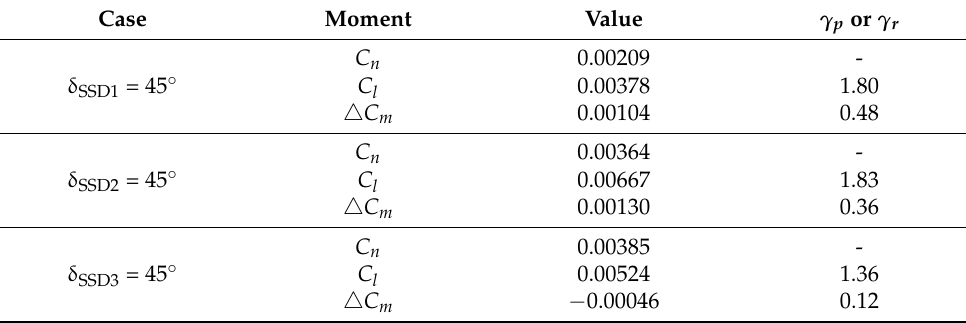
Figure 9. Spatial streamlines near the control surface and Cp distributions around SSDs, Ma = 0.2, Re = 3.98 × 10 7 , α = 6 ◦ : ( a ) SSD1; ( b ) SSD2; ( c ) SSD3. Table 4. Aerodynamic moments characteristics of the SSDs at α = 6 ◦ .